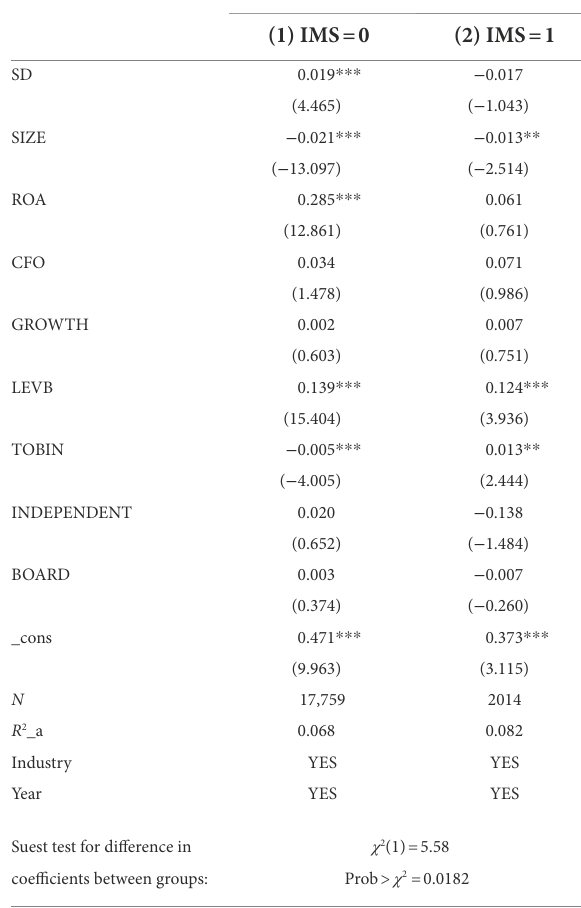
TABLE 7 Auditors’ industry expertise, strategic differentiation, and firm leverage